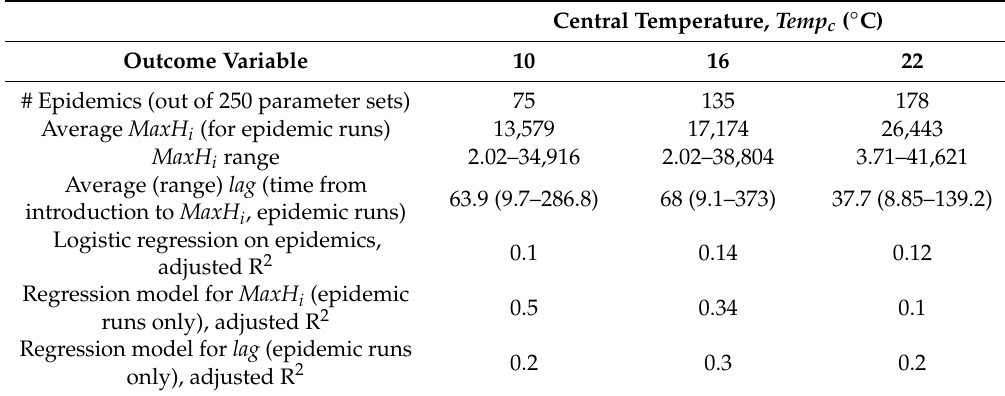
Figure 3. Model behavior. Two simulation runs with different parameters showing ( A ) single and ( B ) bimodal outbreaks. Top panels, number of humans in each class, lower panels, number of adult female mosquitoes of each species in each class. ( A ) Run 67, ( B ) run 249. Parameters given in Table S6. Temp c = 22 °C. Blue lines, susceptible; red lines, infectious humans or mosquitoes; and green lines, recovered humans. Mosquito panels set to the same Y-axis scaling for comparison; infectious mosquitoes not always visible at this scale. Table 2. Outcome variables for sensitivity analysis at three values of Temp c